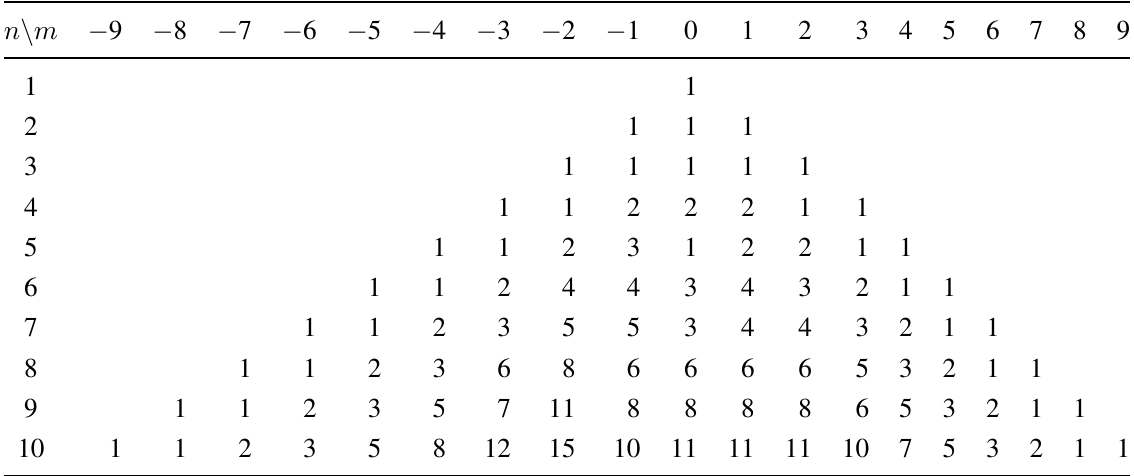
Table 2. A table of values of T ( m, n )